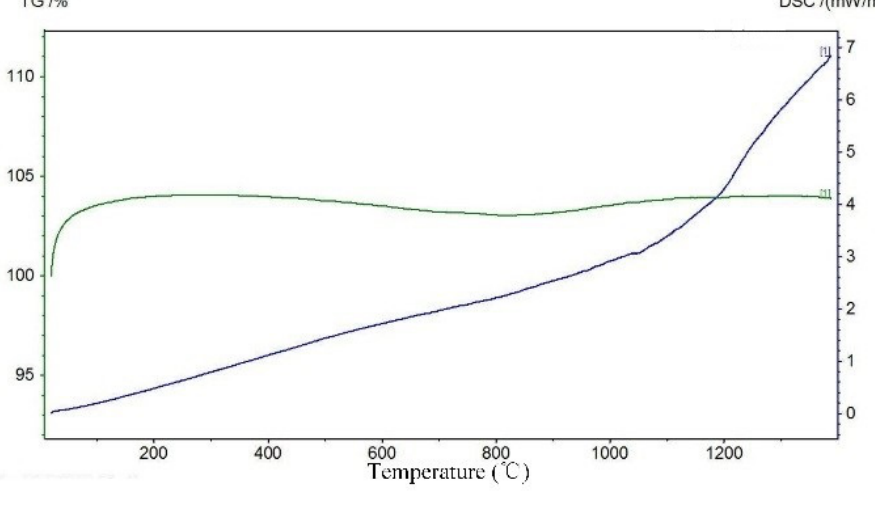
Figure 5. TG-DSC curves of